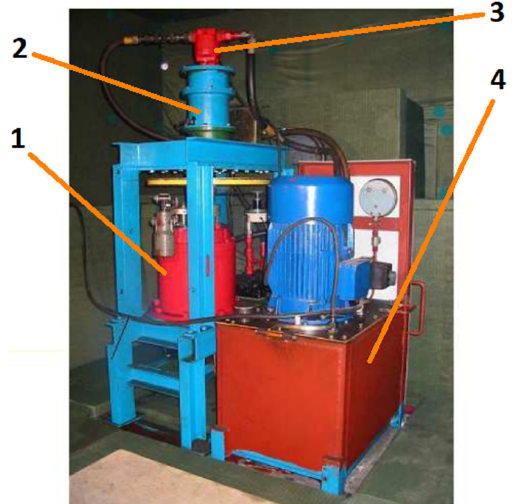
Figure 13. The hydrostatic transmission test stand: 1—planetary gear; 2—coupling housing; 3—hydraulic gear motor; 4—hydraulic power source.